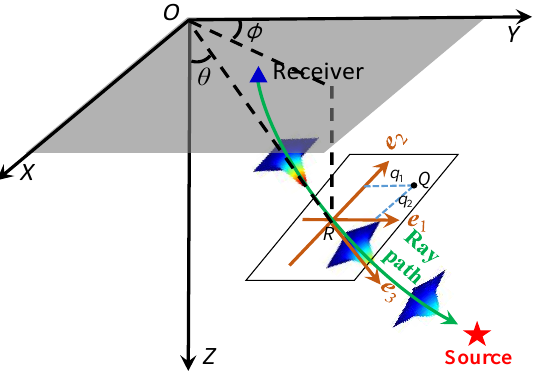
Figure 1. Central ray coordinate system of the 3D Gaussian beam wavefield modeling.